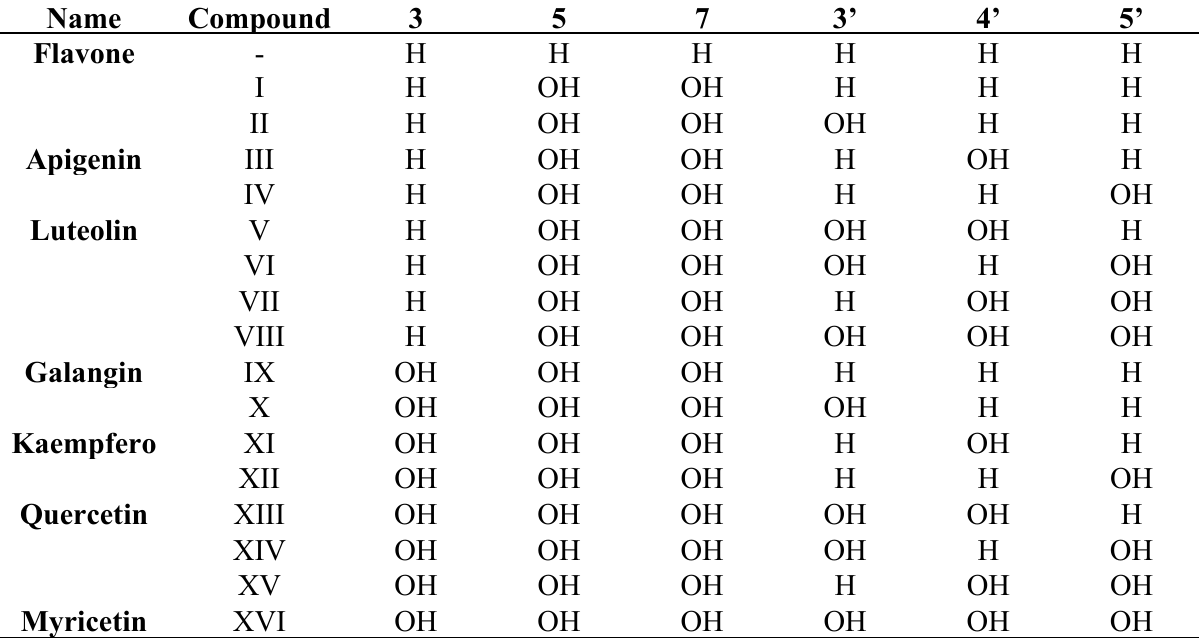
Table 1. Flavone derivatives, flavonoids, together with the numbering code used throughout this work. The first row of numbers indicates the molecular position, with numbering as in Figure